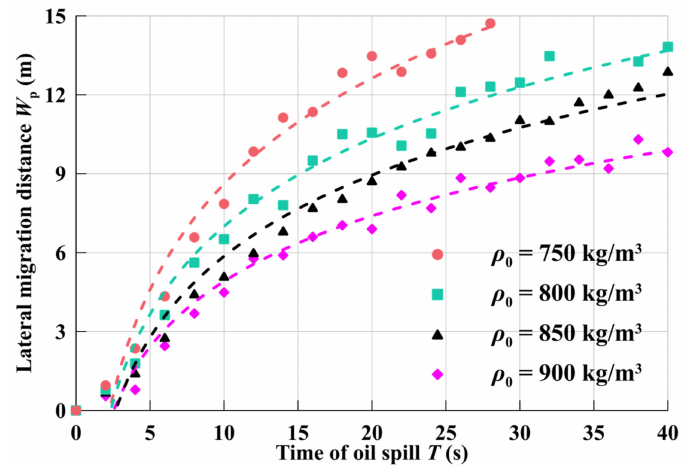
Figure 11. Lateral migration distance of spilled oil for three different oil densities. ( U P = 0.10